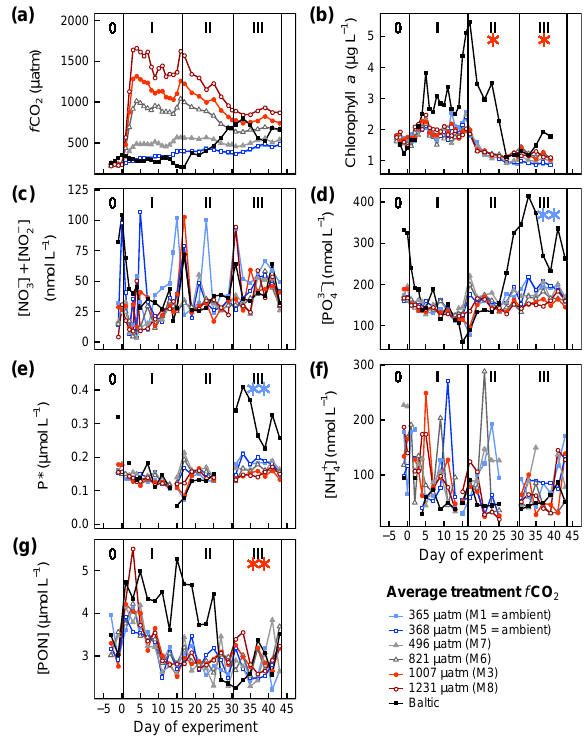
Figure 1. Temporal development in (a) calculated f CO 2 using measured dissolved inorganic carbon (DIC) and pH T , (b) chloro- phyll a concentrations, (c) dissolved inorganic nitrate concentra- tions, (d) dissolved inorganic phosphate concentrations over the study period, (e) excess dissolved inorganic phosphate concentra- tions (P*) calculated according to Eq. (1), (f) measured dissolved ammonium concentrations and (g) suspended particulate organic nitrogen concentrations. Data for (a–d) , and (f–g) are from Paul et al. (2015). * = p< 0 . 05, ** = p <0.01, where red indicates posi- tive and blue a negative detected effect of f CO 2 . Average treatment f CO 2 was calculated for each mesocosm between t 1 and t